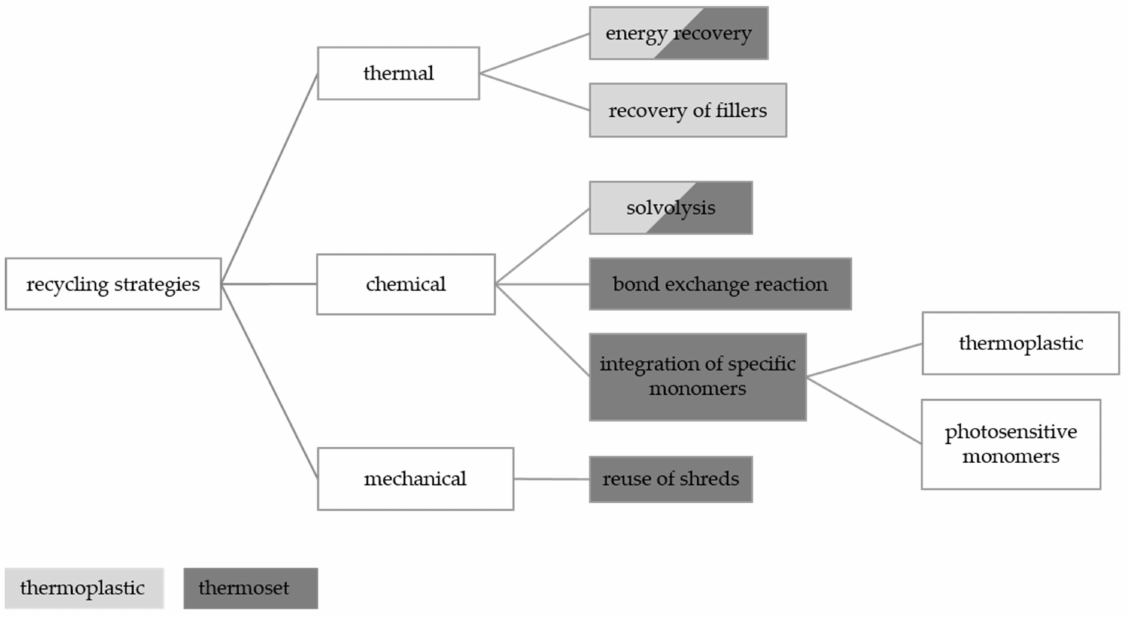
Figure 1. Overview of different recycling strategies and the potential of implementation on thermo- plastics or